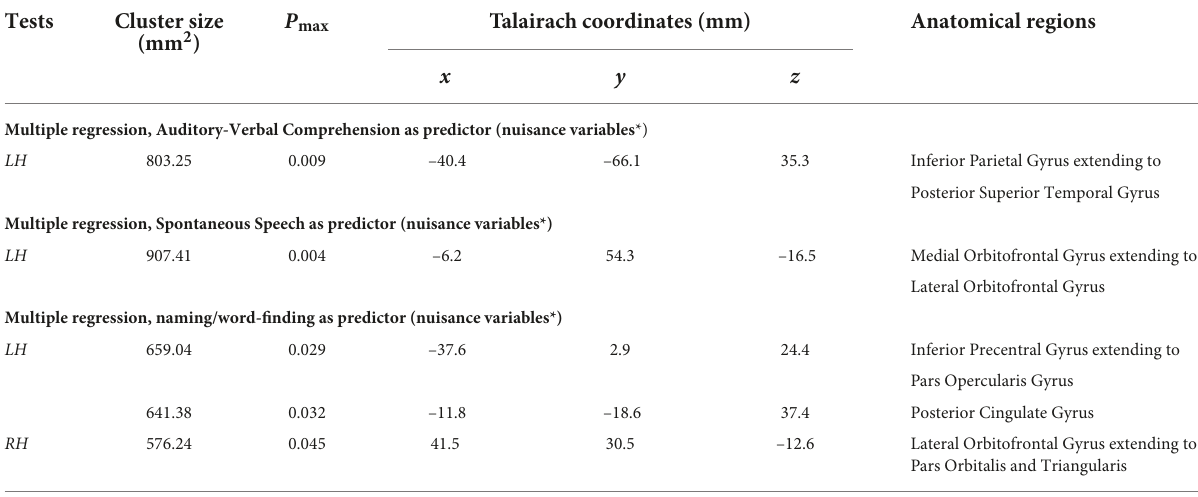
TABLE 2 Clusters of cortical thickness related to language performance in